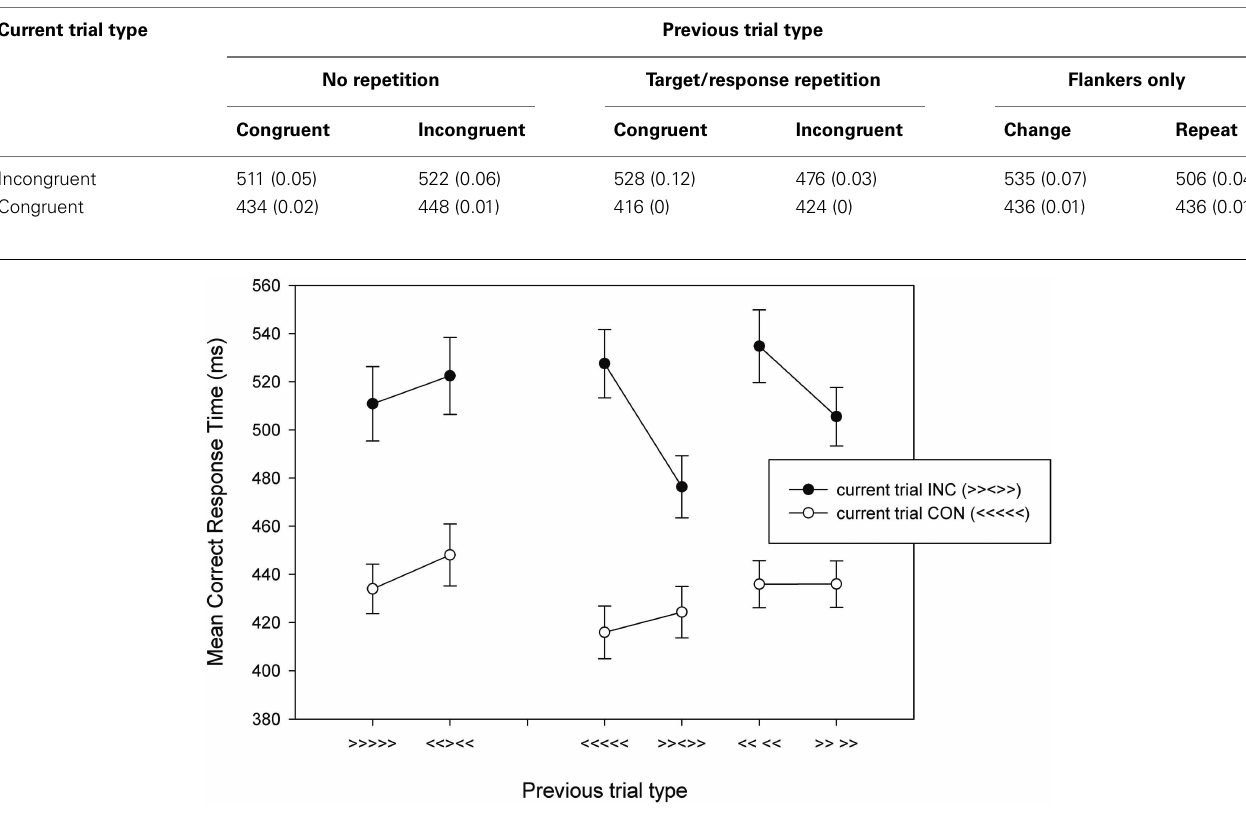
Table 3 | Mean correct response times (in ms) and error rates (in brackets), separated by previous trial type, current trial type, repetition, and flanker only trials.